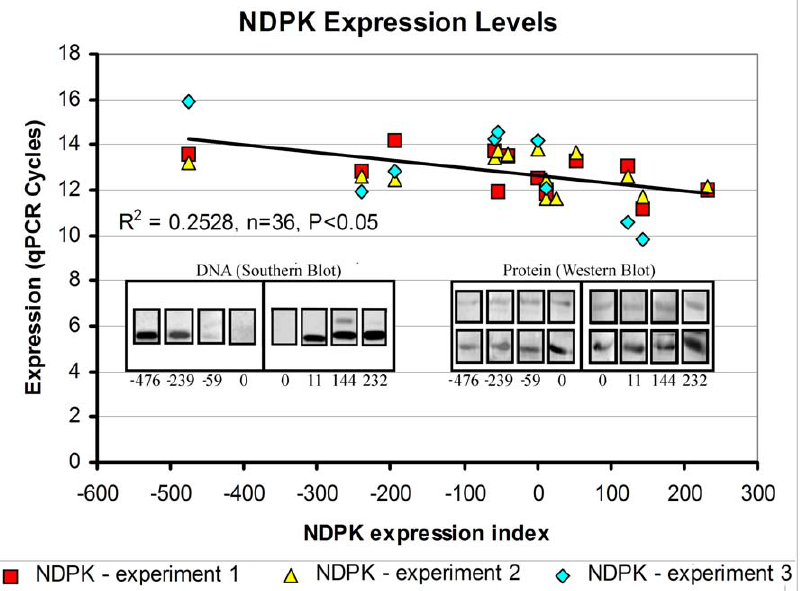
Figure 2. NDPK expression levels were altered in the transformants. Semiquantitative RT-PCR was performed three times for each of 12 transformants and the wild type strain and the threshold values obtained in each of the three experiments were plotted against the measured copy number data. Negative copy numbers refer to the antisense construct and positive copy numbers to the overexpression construct. These results show that NDPK expression levels were decreased in the antisense transformants and increased in the overexpression transformants giving an overall difference in expression of as much as 8-16 fold. The correlation was significant at P , 0.05 (Pearson product moment correlation coefficient r ). It accounts for about 25% of the variance in the qPCR threshold cycle number (R 2 =0.253), while the remainder reflects experimental error inherent in the qPCR and copy number measurements. Copy number was calculated by quantitative southern blotting. The inset on the left depicts the southern blots for several representative transformants and shows that the copy number varies between transformants. NDPK protein levels were also determined through western blotting and the results of several transformants are depicted in the inset labelled protein (western blotting). The upper panels in the western blots show the B-actin bands detected in the same blot as a loading control using a commercial